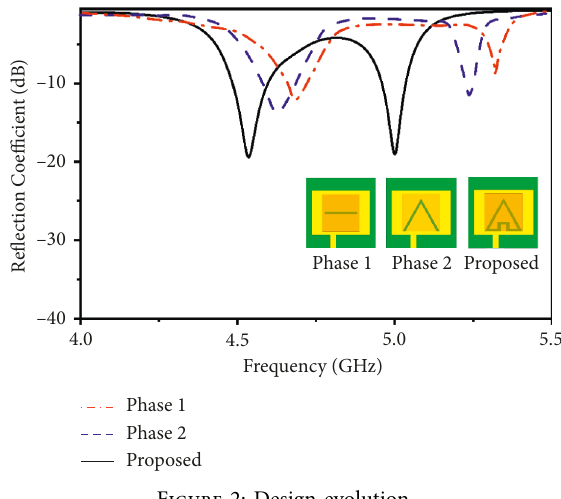
Figure 2: Design